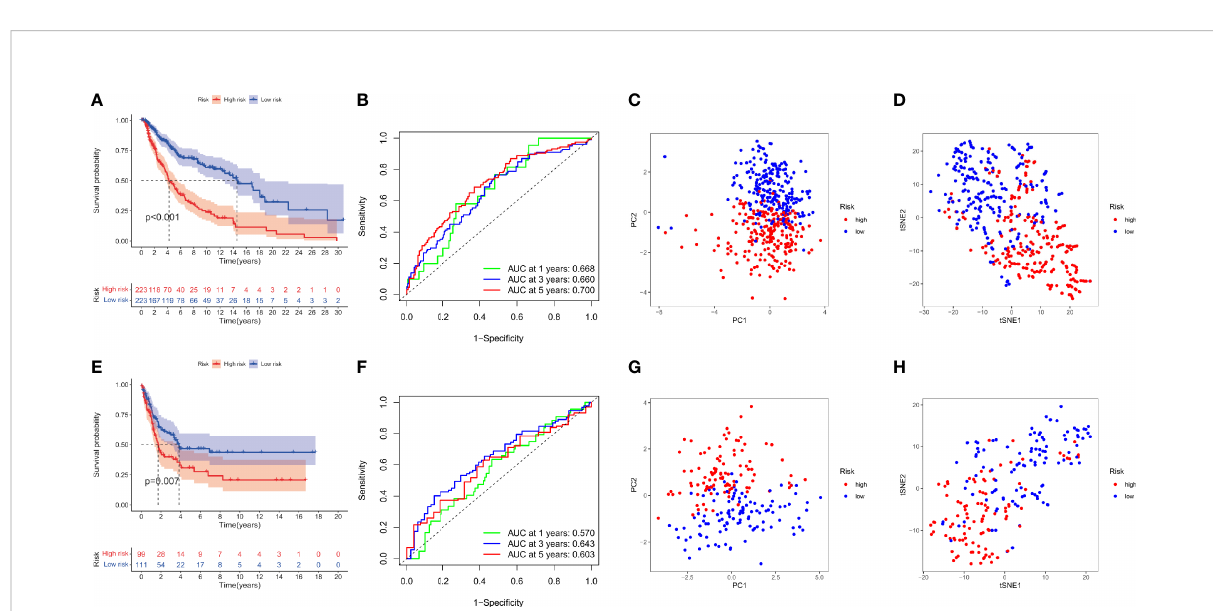
FIGURE 4 DRRGs signature based on training (TCGA-SKCM) and testing (GSE65904) cohorts. (A) KM plot of DSS premised on the risk scores; (B) ROC for DSS; (C) PCA plot; (D) t-SNE analysis in the training cohort (TCGA-SKCM); (E) KM plot of DSS premised on the risk scores; (F) ROC for DSS; (G) PCA plot; (H) t-SNE analysis in the test cohort (GSE65904).